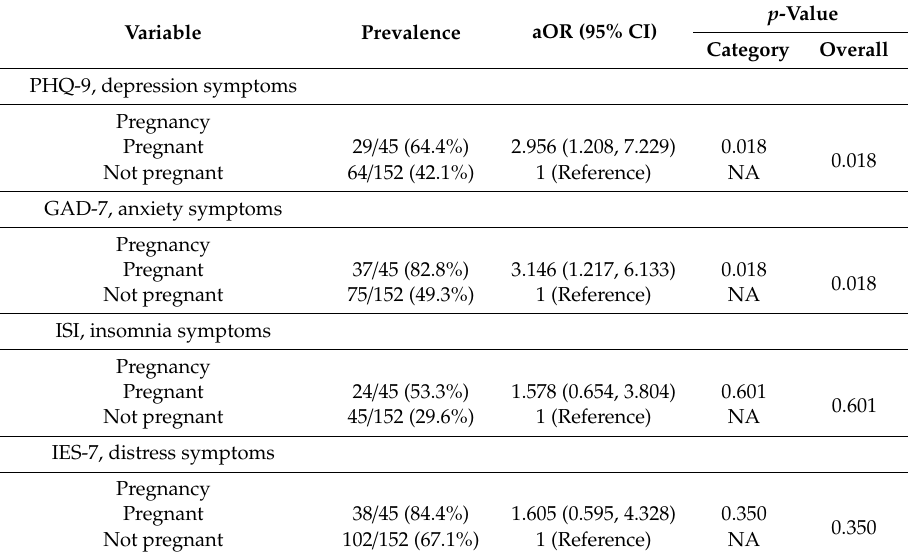
Table 2 lists the detailed results of PHQ-9 from multivariable logistic regression analysis; the results for the other scales are presented in Supplementary Materials (Tables S1–S3). Abbreviations: NA = Not Available; aOR: adjusted odds ratio; CI: confidence interval. PHQ-9: the Patient Health Questionnaire-9. Table 3. Prevalence rates of mental symptoms and associated factors in female cohort.